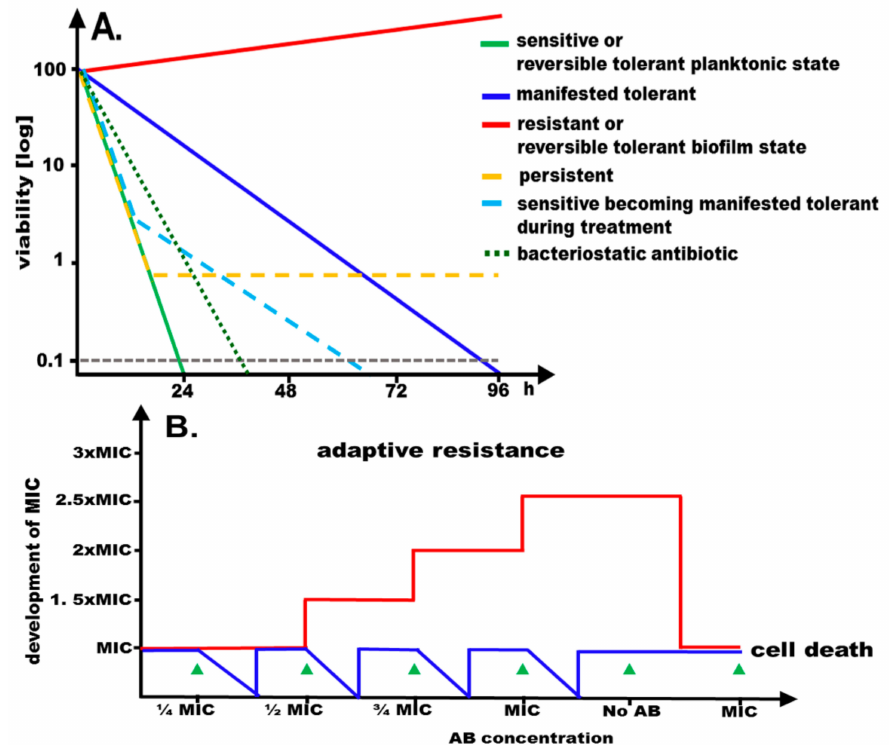
Figure 1. Consequences of exposure to antimicrobials. ( A ) Graphical representation of time- dependent development of viability of a sensitive, resistant, persistent, manifested tolerant and reversible tolerant microbial population to a bactericidal antimicrobial at the minimal inhibitory concentration (MIC). A time course of a hypothetical antibiotic experiments is shown with bacterial cells subjected to the antibiotic at MIC with cellular viability monitored over time. While the majority of cells of a sensitive population are readily killed (>99.9% killing after 24 h; green line), cells of the resistant population continue to grow (red line). Cells of a manifested tolerant population display prolonged viability as compared to sensitive cells (blue line). Upon exposure of a sensitive population with a large fraction of persister cells to the antimicrobial (yellow line), the majority of the cells are killed, but a subpopulation remains viable for an extended period. Upon exposure of a sensitive population to an antimicrobial, manifested tolerance can emerge (light blue line). Biofilms display a reversible tolerance phenotype, showing apparent resistance at the MIC of the planktonic state. The decrease in viability for a bacteriostatic antibiotic is shown for comparison (90–99% killing after 24 h; dotted dark green line). ( B ) Repeated exposure to increasing concentrations of antibiotic below the MIC followed by regrowth can lead to adaptive resistance, which is reversed upon removal of the antibiotic. Red line, development of the minimal inhibitory concentration; blue line, development of